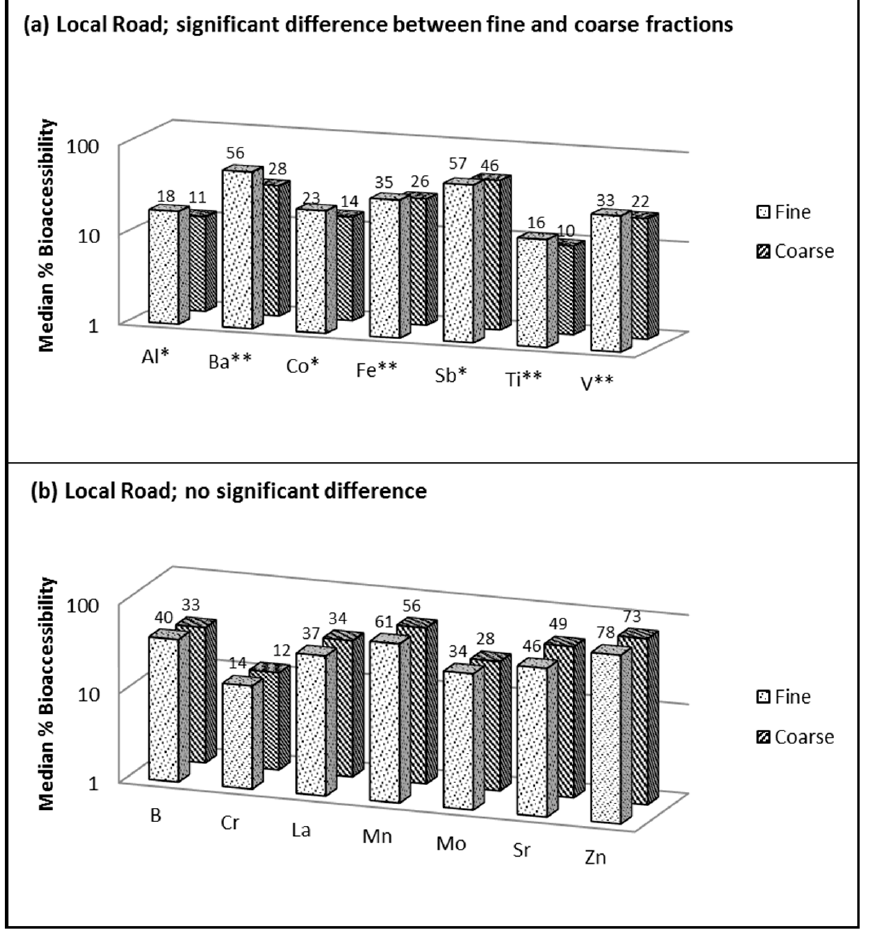
Figure 3. Bioaccessibility of fine versus coarse fractions of resuspended road dust when using 0.1 M ammonium citrate (pH 4.4) showing ( a ) significant difference between fractions and ( b ) no significant difference; fine = <1.8 µm and coarse = 1.8–10 µm; * significant at p < 0.05; ** significant at p < 0.01.